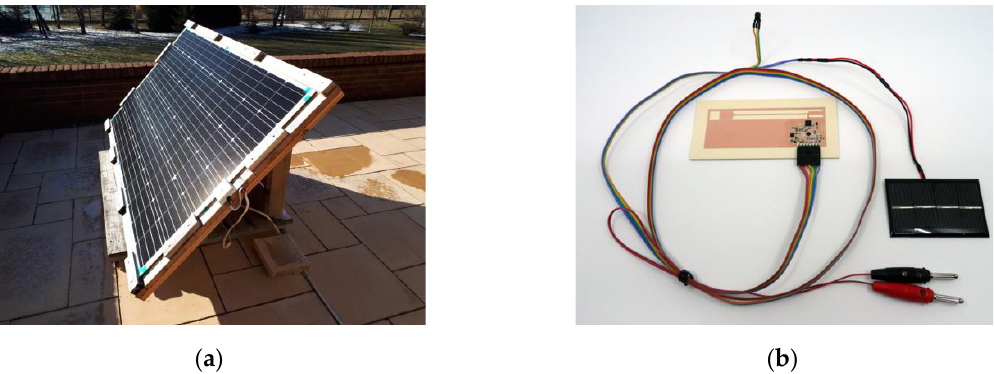
Figure 12. Outside tests: ( a ) measurement application; ( b ) test sample of RFID sensor with external sensors.